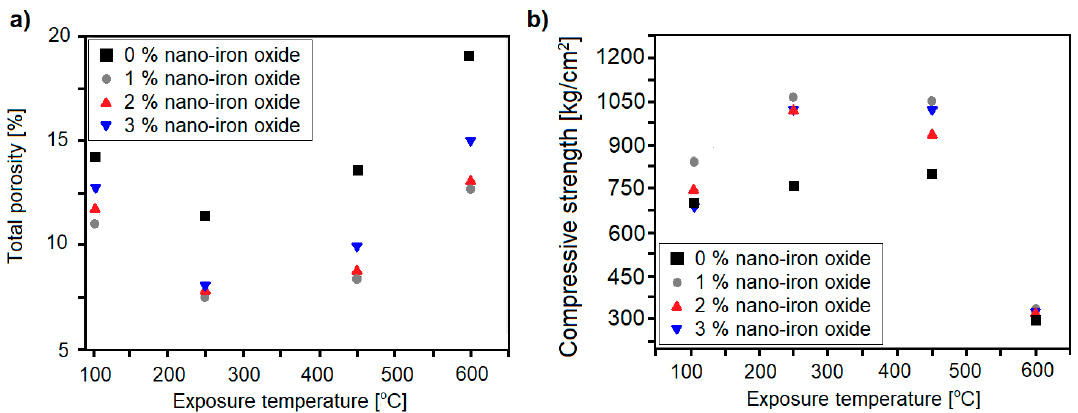
Figure 16. Total porosity ( a ) and compressive strength ( b ) of cement pastes containing nano-iron oxide, as a function of temperature. Redrawn from [72].